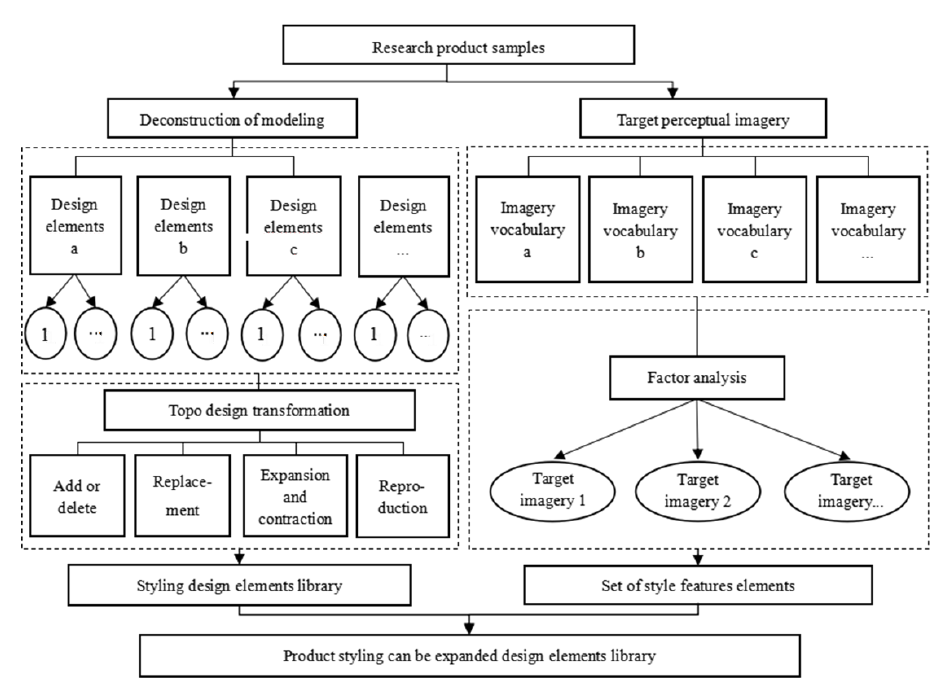
Figure 2. Product shapes can be a topological design elements library.